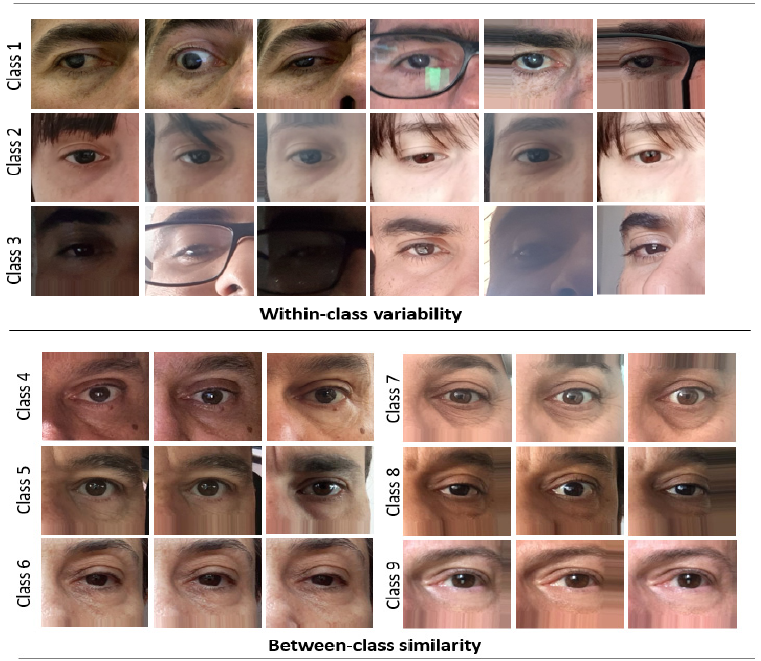
Figure 3. Within-class variability and between-class similarity challenges for periocular recognition in the wild. Here we show some examples for each challenge obtained from UFPR